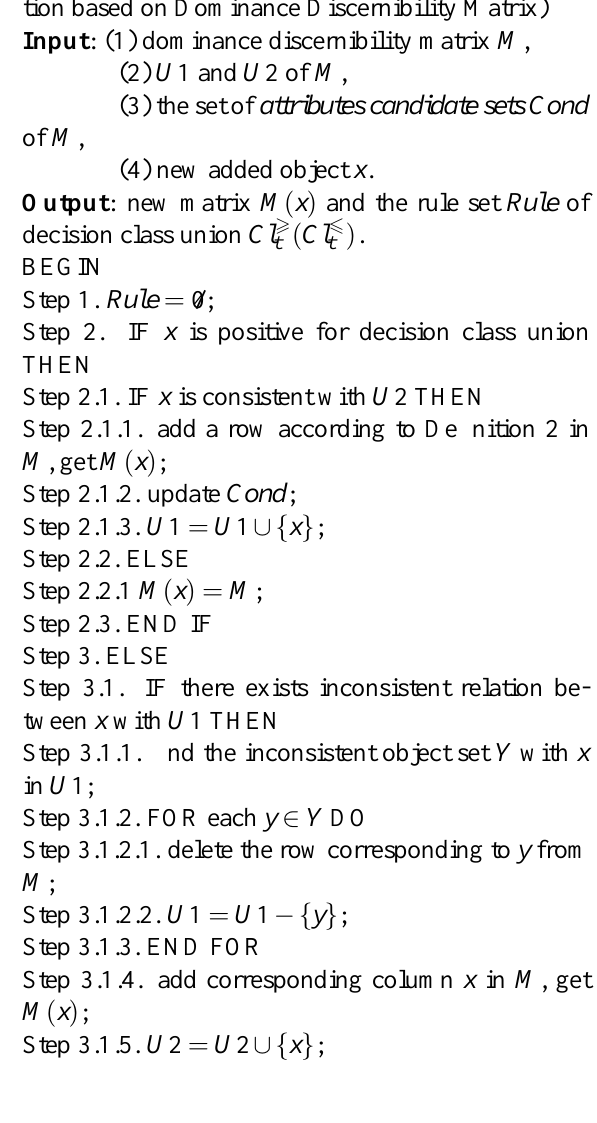
Algorithm 2. INRIDDM(INcremental Rule Induc- tion based on Dominance Discernibility